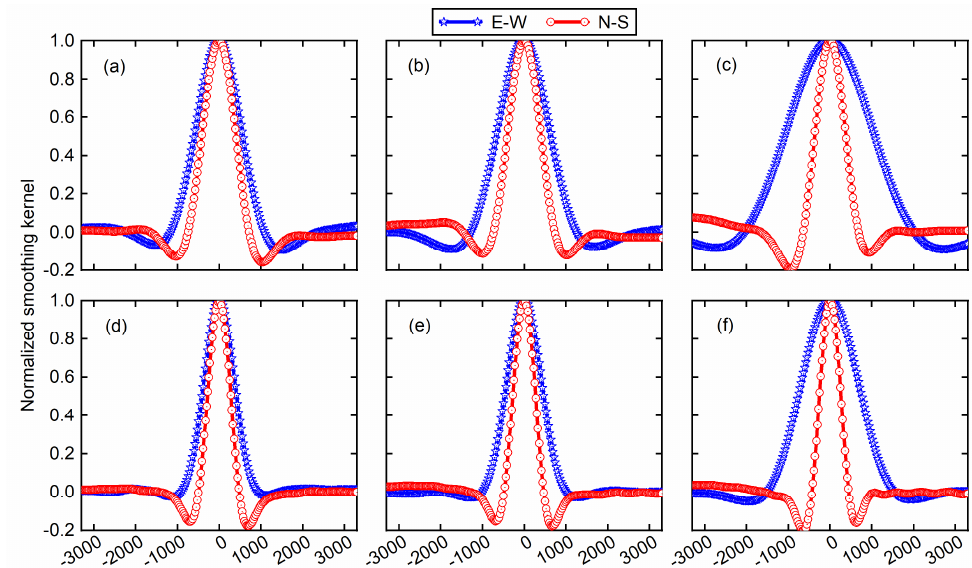
Figure 3. The normalized smoothing kernel weights with kernel center located at different latitudes: 0° ( a , d ), 30° ( b , e ), and 60° ( c , f ) along the 0° meridian. The adaptive DDK filters for September 2006 ( a , b ) and July 2010 ( d – f ) with power indices selected as 6.5 and 3.4, and with regularization coeffi- cients selected as 1 × 10 15 and 5 × 10 18 , respectively.